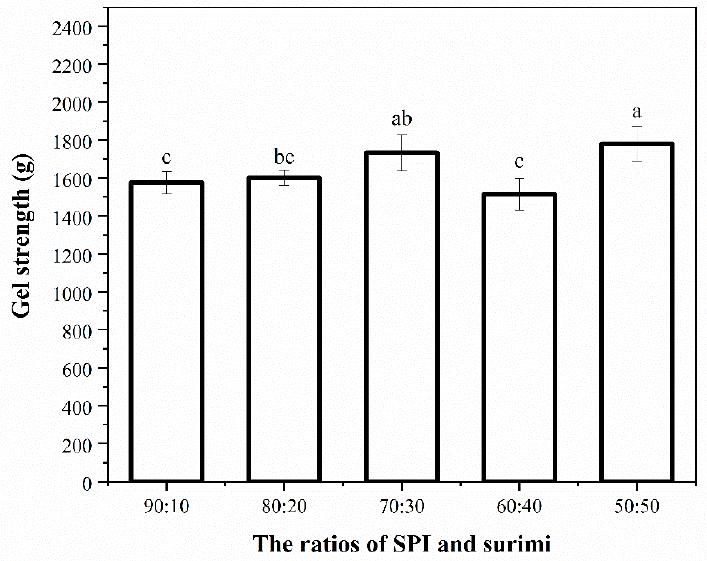
Figure 2. The heat-induced gel strength of the SPI and surimi blends at different ratios. Different letters mean significant differences ( p < 0.05). Table 1. Textural properties of the extrudates at different SPI and surimi